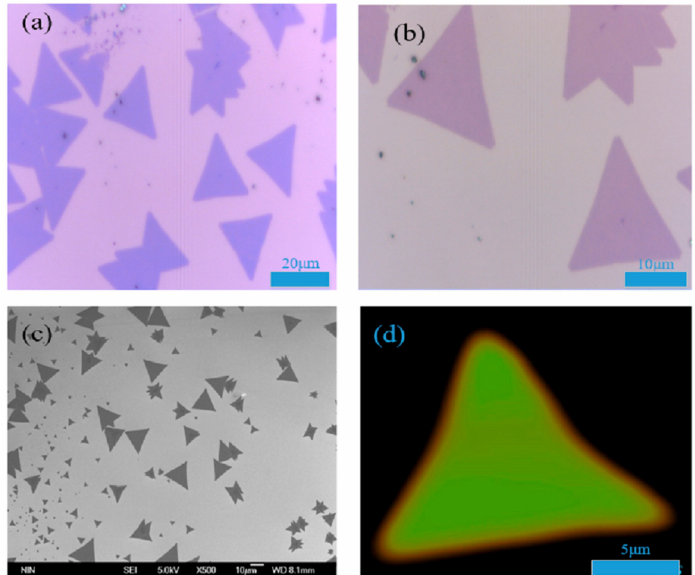
Figure 1. ( a ) The 50 × objective optical micrograph of monolayer MoS 2 ; ( b ) the 100 × objective optical micrograph of monolayer MoS 2 ; ( c ) the FESEM image of triangular monolayer MoS 2 ; and ( d ) the mapping diagram of monolayer MoS 2